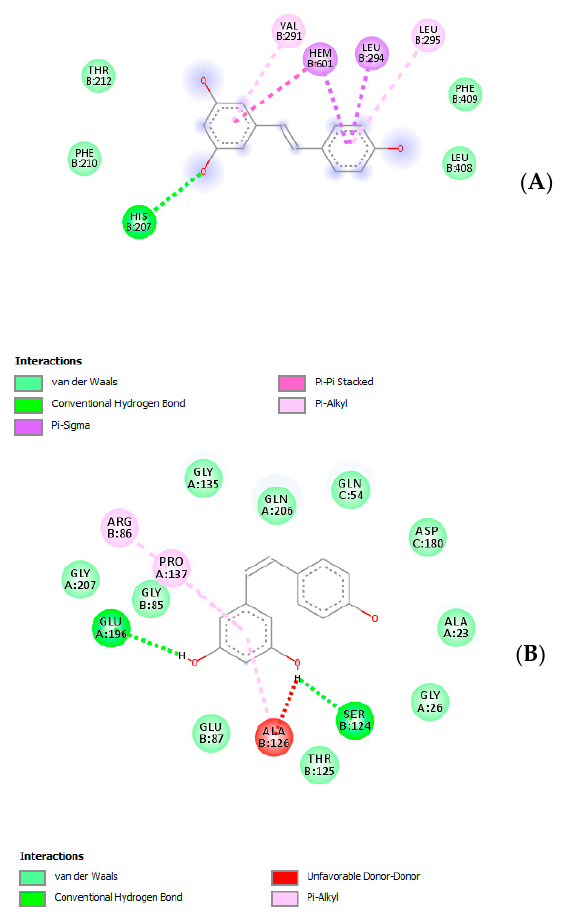
Figure 8. ( A ) Putative interactions between resveratrol and cyclooxygenase-1 (COX-1; PDB: 1EQG). Free energy of binding ( ∆ G) and a ffi nity (Ki) are − 7.8 kcal / mol and 1.9 µ M, respectively. ( B ) Putative interactions between resveratrol and carbonic anhydrase-IX (CA-IX; PDB: 5FL6). Free energy of binding ( ∆ G) and a ffi nity (Ki) are − 7.3 kcal / mol and 4.5 µ M, respectively.